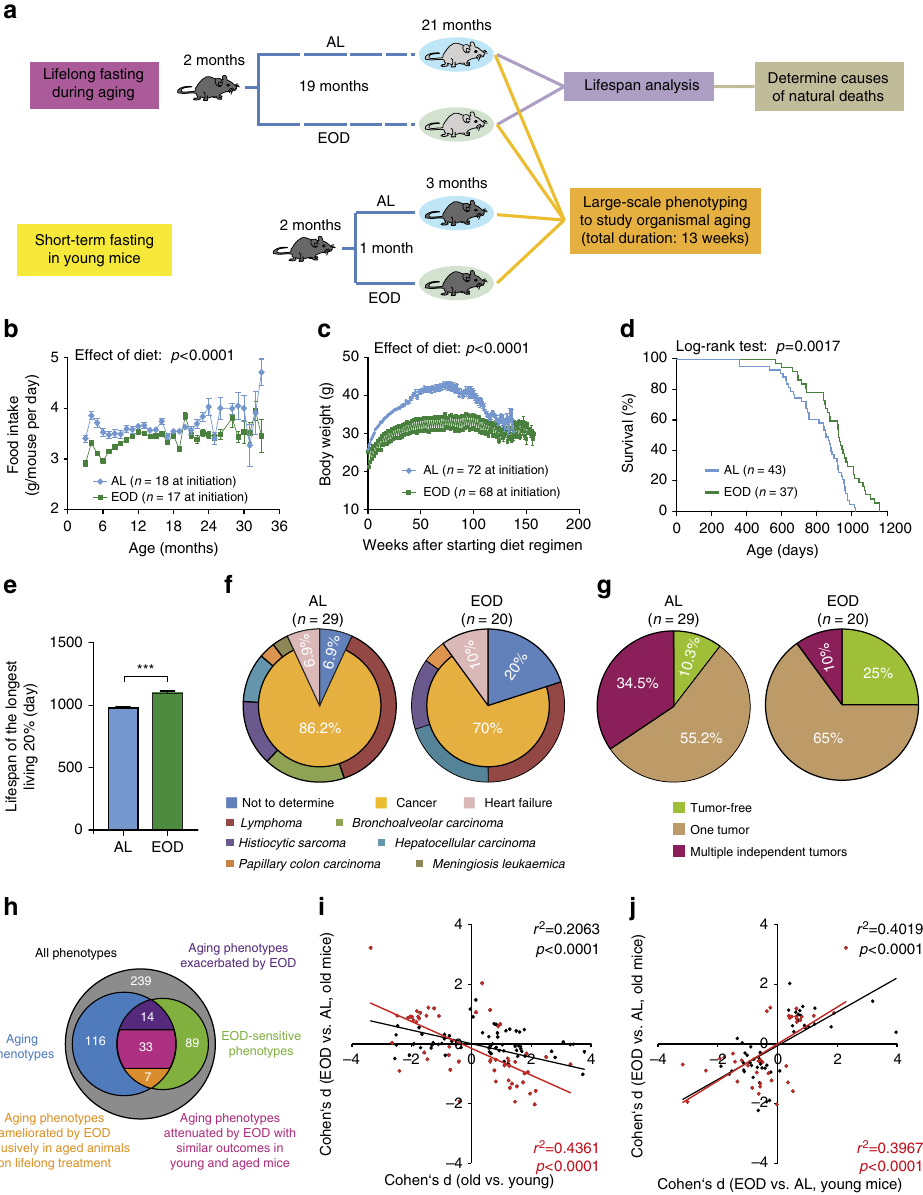
Fig. 1 EOD extended lifespan and delayed lethal neoplastic disease but had limited effects on aging rate. a Schematic illustration of the experimental design. b Estimated food intake per animal (number of cages at initiation AL: n = 18, EOD: n = 17). c Body weight (AL: n = 72 mice, EOD: n = 68 mice at initiation). Statistical analyses for b and c were performed using a mixed effects model with DR as fi xed effect and cage and time as random effects. d Survival curves (log-rank test; AL: n = 43 mice, EOD: n = 37 mice). e Maximum lifespan was calculated from the longest living 20% ( t -test; AL: n = 9 mice, EOD: n =